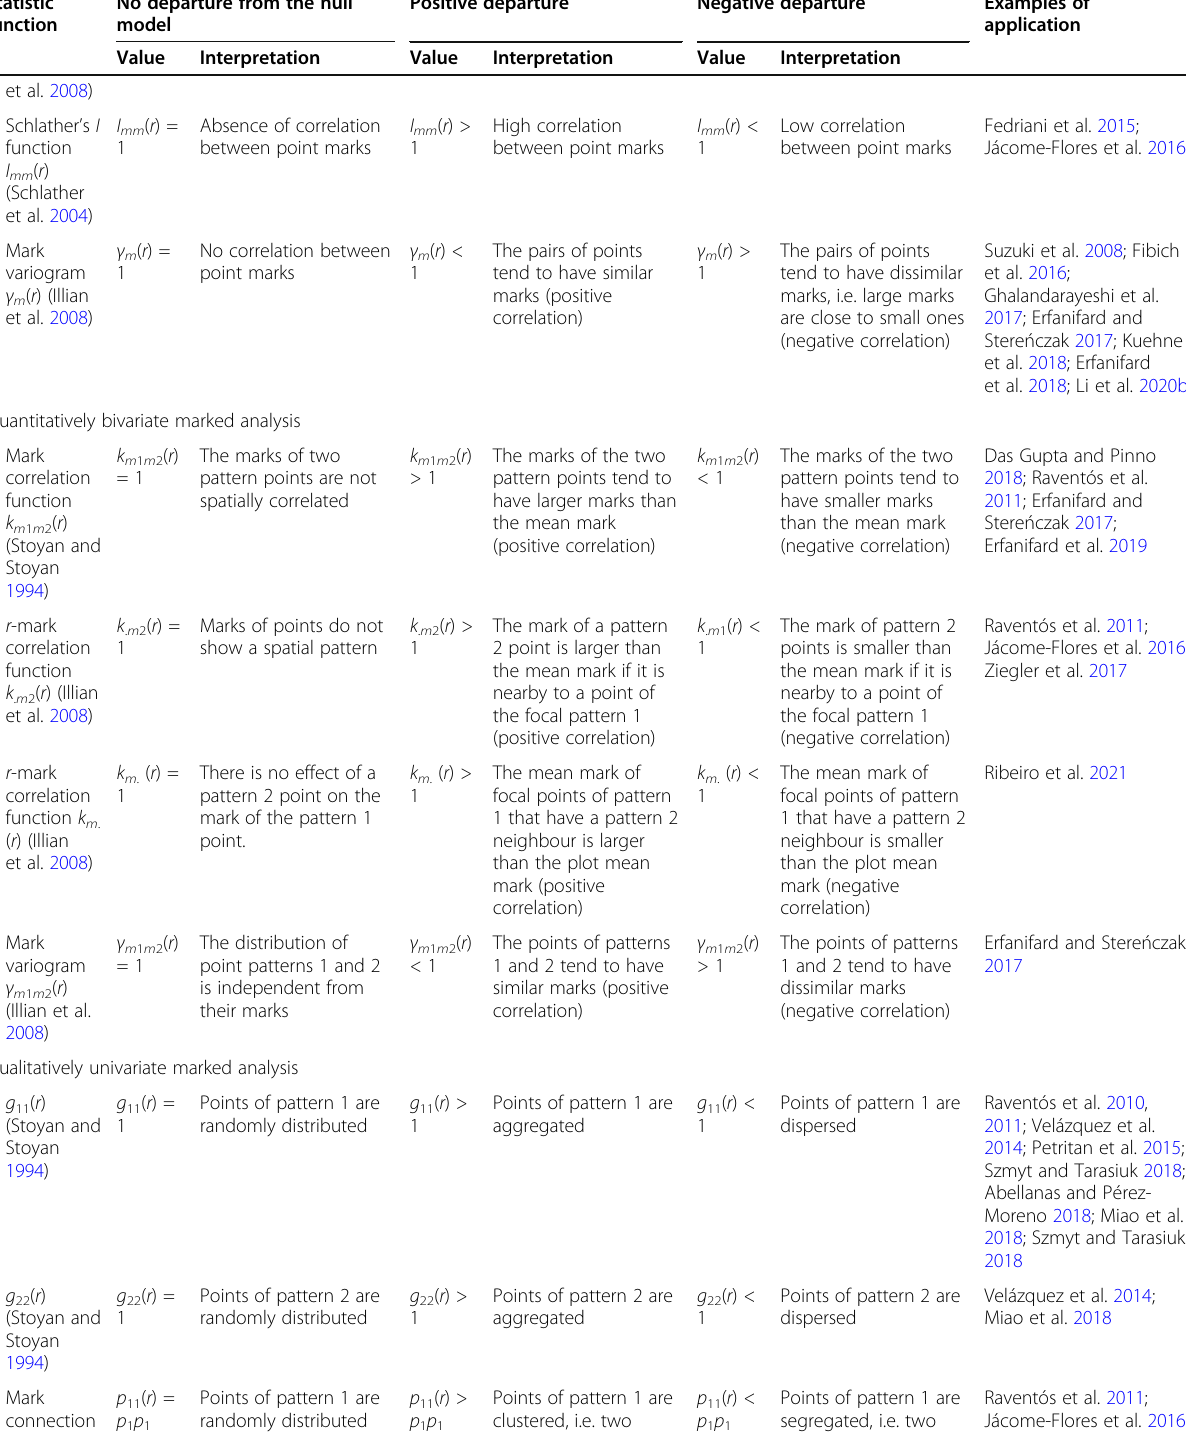
Table 1 Second-order summary statistics commonly used in spatial point-pattern analysis. In the univariate analysis, only one pattern is involved (e.g. one species, one size or age class, one life stage, etc.), while in the bivariate version two patterns (1 and 2) are investigated (e.g. two different species, two size classes, two life stages, etc.). For the mark correlation analysis, the most studied mark is by far tree diameter. In the case of random labelling analysis, the marks usually consist of tree status (e.g. dead vs living). For all analysis types, positive, negative, or absence of departure from the null model simulation envelopes occurs at a given scale